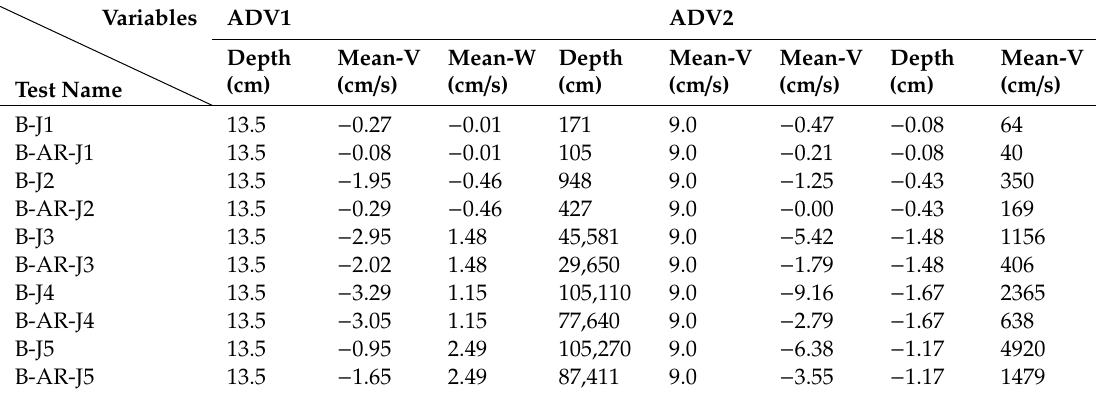
Table 4. Mean velocity and TKE at ADV1 (x = 6.1 m) and ADV2 (x = 7.0 m) under irregular wave climates (depth is distance between the probe and water surface).